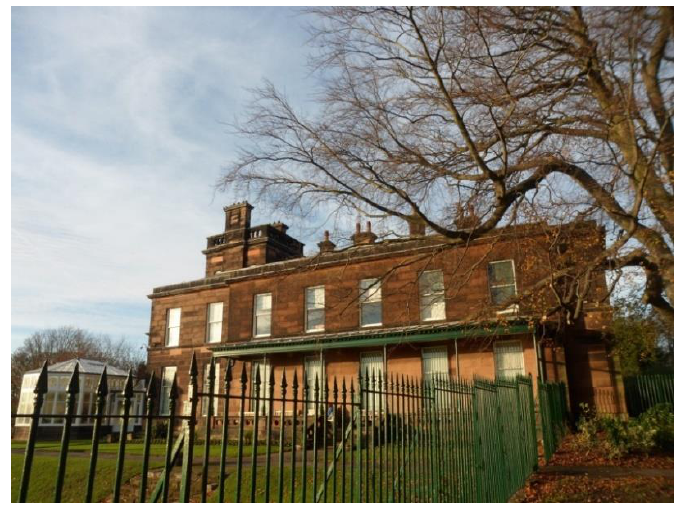
Figure 14. Example of museums promoting respect and social inclusion (P15) (Sudley House, Liverpool).